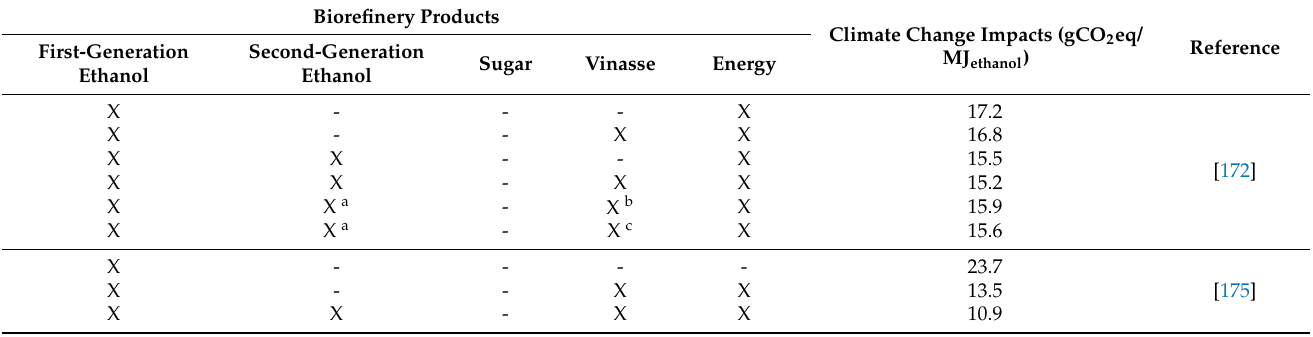
Table 4. Climate change impacts per unit of ethanol energy produced in different configurations and scenarios of biorefineries for ethanol production. “X” indicates if a specific step is present. Generally, scenarios including 2 nd generation ethanol production and vinasse biodigestion have a lower